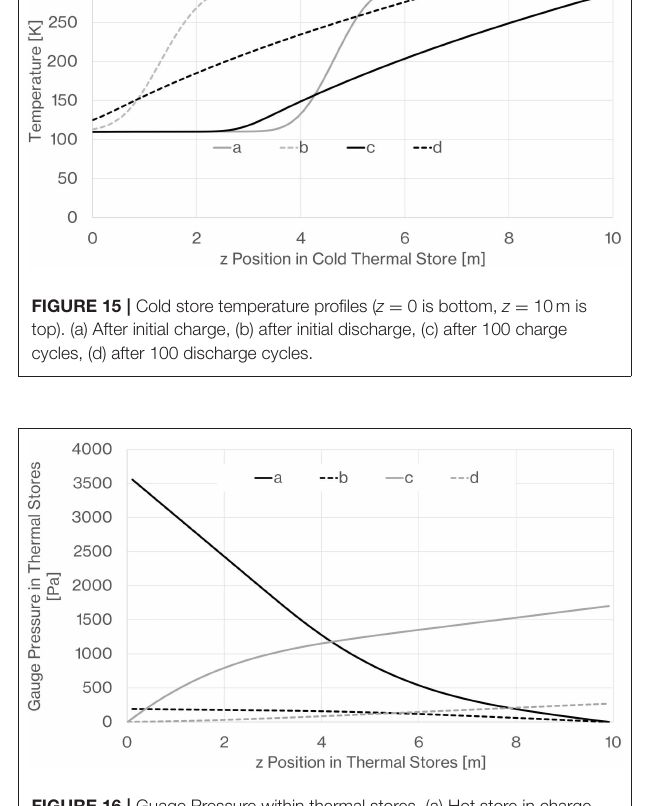
FIGURE 16 | Guage Pressure within thermal stores. (a) Hot store in charge mode at end of charge cycle, (b) cold store in charge mode at end of charge cycle, (c) hot store in discharge mode at end of discharge cycle, (d) cold store in discharge mode at end of discharge cycle.